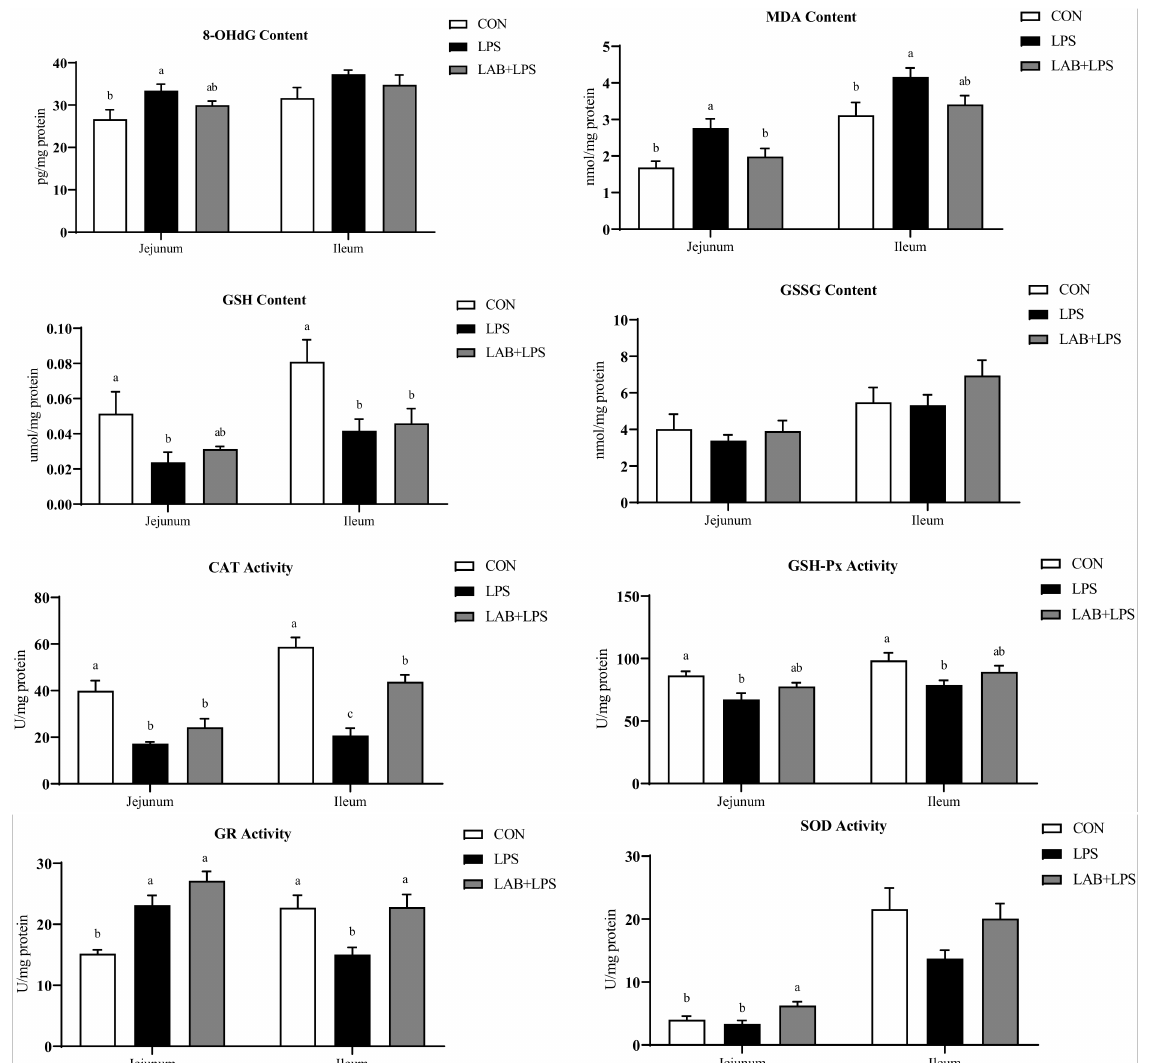
Figure 2. The effects of LAB supplementation on the intestinal mucosal oxidative statuses of weaned piglets. Data are presented as means ± SEM ( n = 6). a,b,c Mean values within a row with different superscript letters indicate significant differences ( p < 0.05). CON—non-challenged piglets fed a basal diet; LPS—LPS-challenged piglets fed a basal diet; LAB + LPS—LPS-challenged piglets fed a basal diet supplemented with 0.2% LAB. 8-OHdG—8-hydroxy-2-deoxyguanosine;